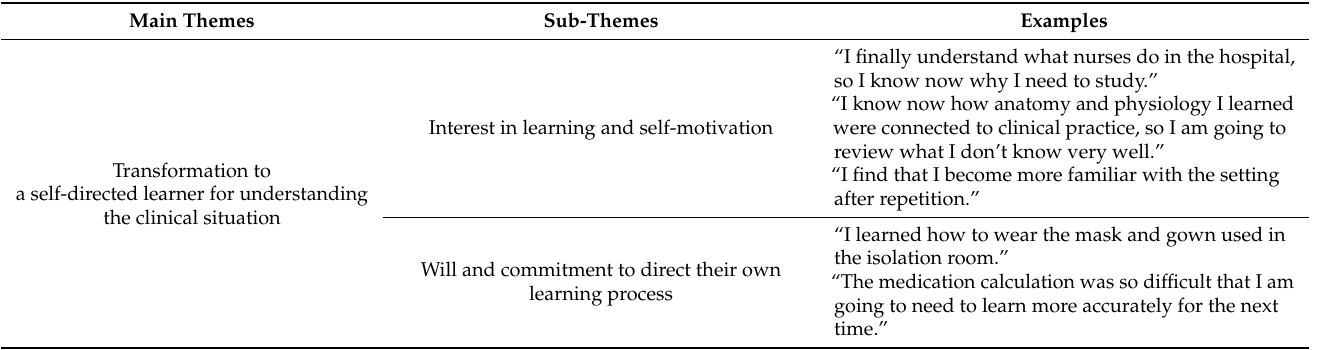
Table 4. Students’ simulation learning experience process based on clinical